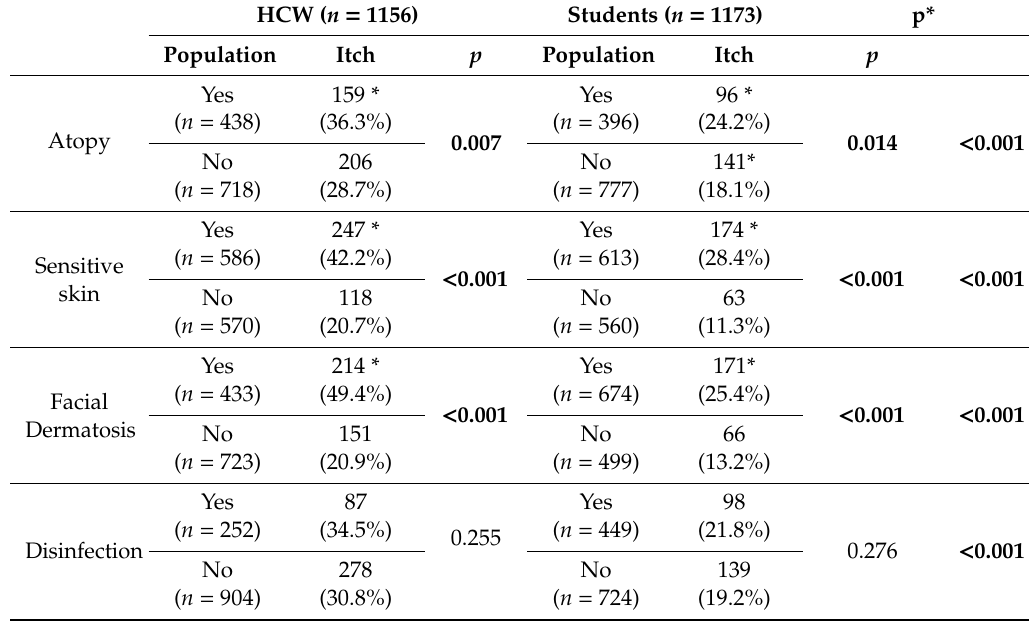
Table 3. Predisposing